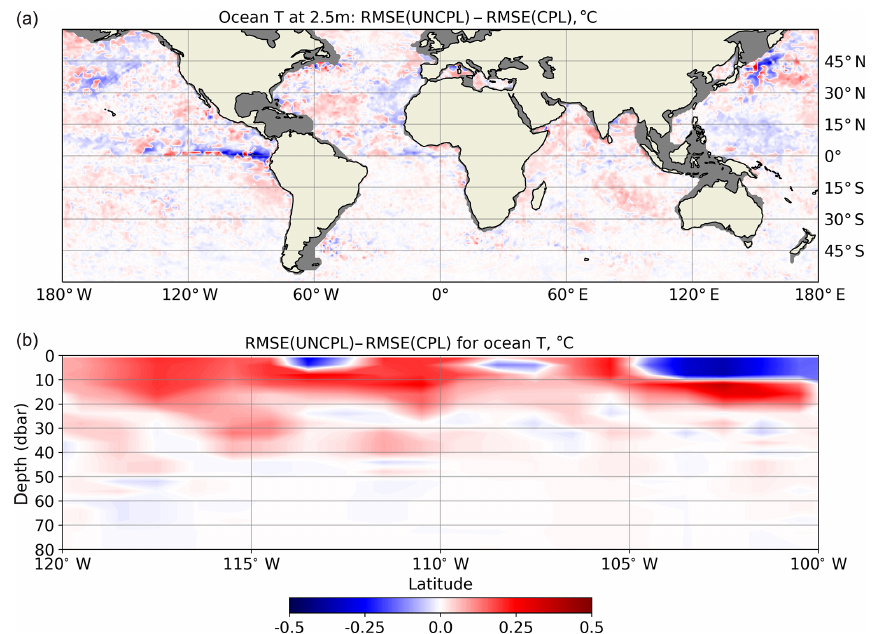
Figure 13. Difference between the UNCPL and CPL (24h forecasts) RMSE ( ◦ C) with respect to the Argo ocean temperature measurements in September 2017. Positive values (red) indicate that the RMSE produced by CPL is smaller, whereas negative values (blue) mean the converse. (a) The RMSE difference for ocean temperature at 2.5m of depth. The grey areas show the regions where Argo measurements were not taken. (b) The temperature vertical section through 1.5 ◦ N latitude in the eastern tropical Pacific Ocean between 120 and 100 ◦